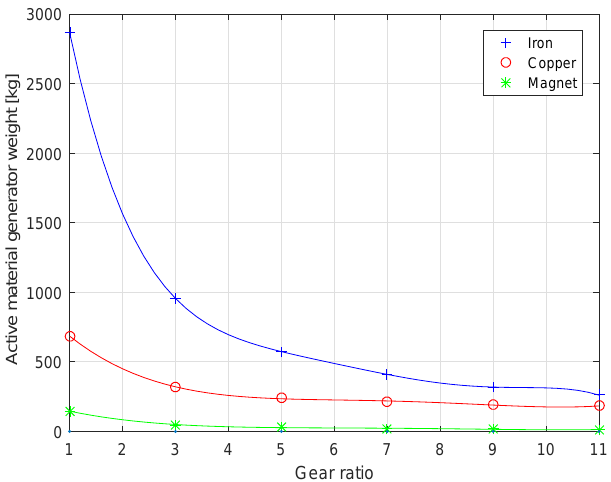
Figure 16. Generator active materials weight for different gear ratios at the power rating of 1.5